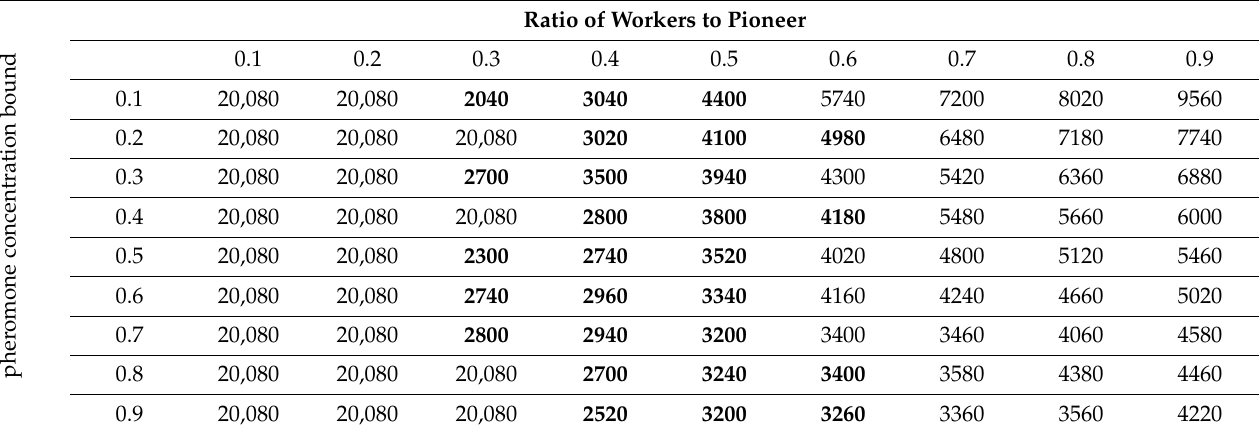
Table 2. Average NOFE with different parameter settings in the sphere function (30 D).